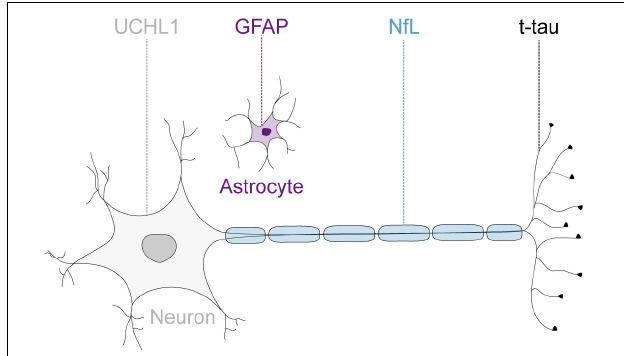
FIGURE 1 | Neuronal and glial biofluid markers of neurodegeneration. The glial fibrillary acidic protein (GFAP) is the main structural protein in astrocytes. The neurofilament-light chain protein (NfL) reflects damage to large-caliber myelinated axons. The microtubule binding protein tau is preferentially localized within thin, non-myelinated axons. The ubiquitin C-terminal hydrolase L1 (UCHL1) is one of the most abundant proteins in the central nervous system and localized mainly in neuronal